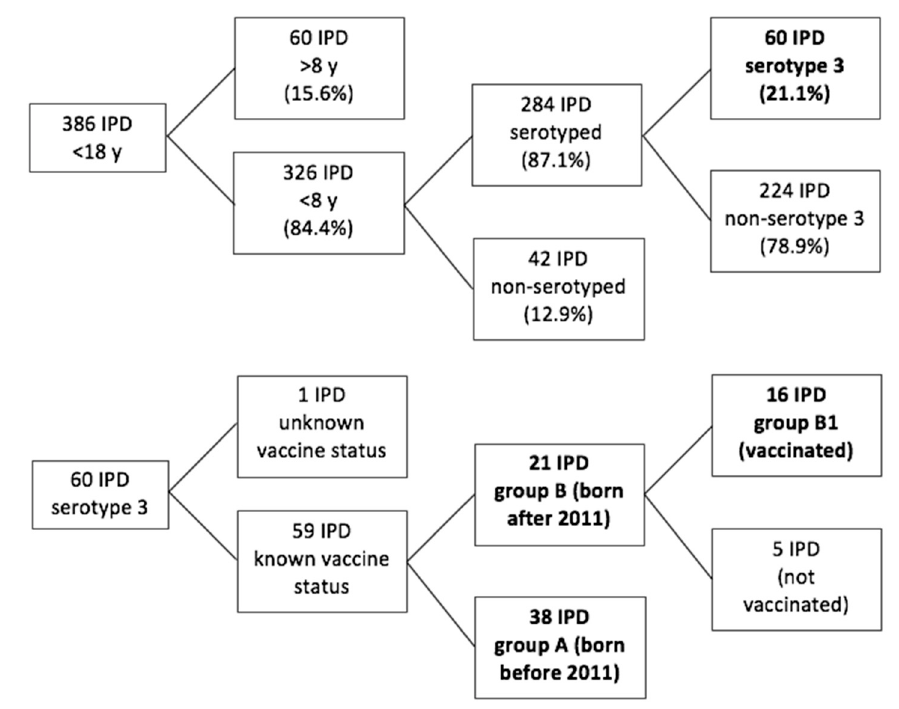
Figure 1. Study design showing the subdivision of the study population and numeric representation of the different study groups. The most relevant study groups are presented in bold. IPD: Invasive pneumococcal disease; y: years of age.